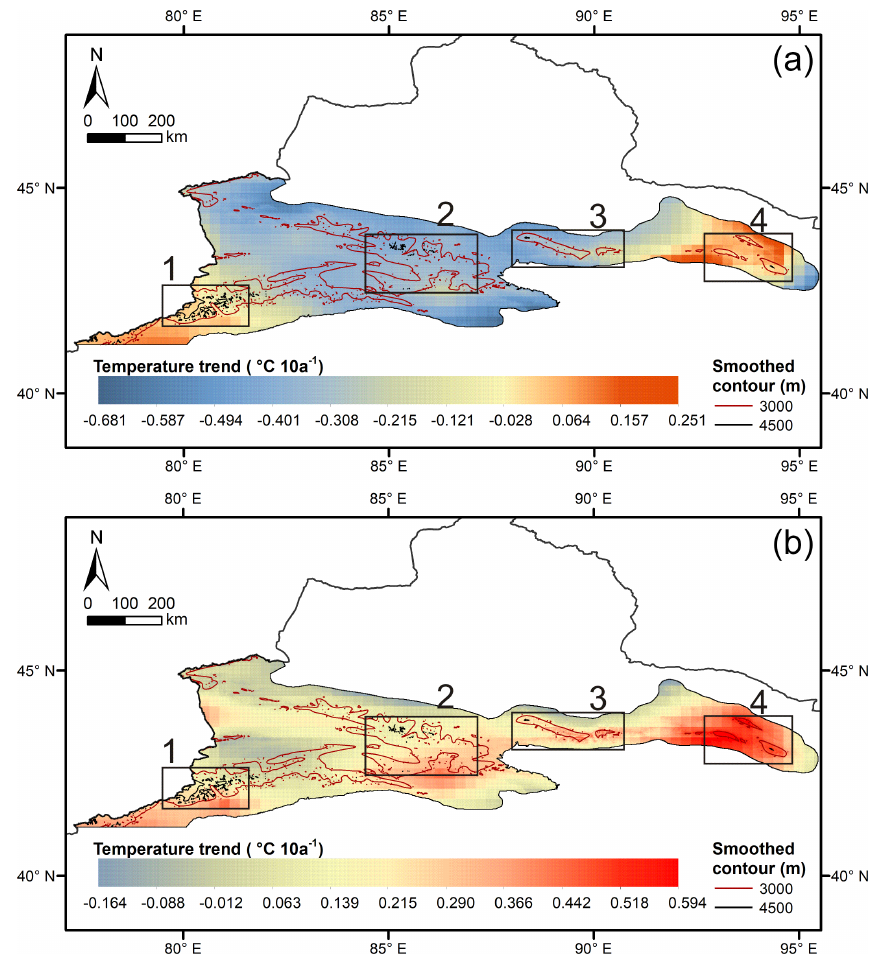
Figure 6. Monthly mean temperature trends in (a) January and (b) February for the entire CTM from 1979 to 2016.